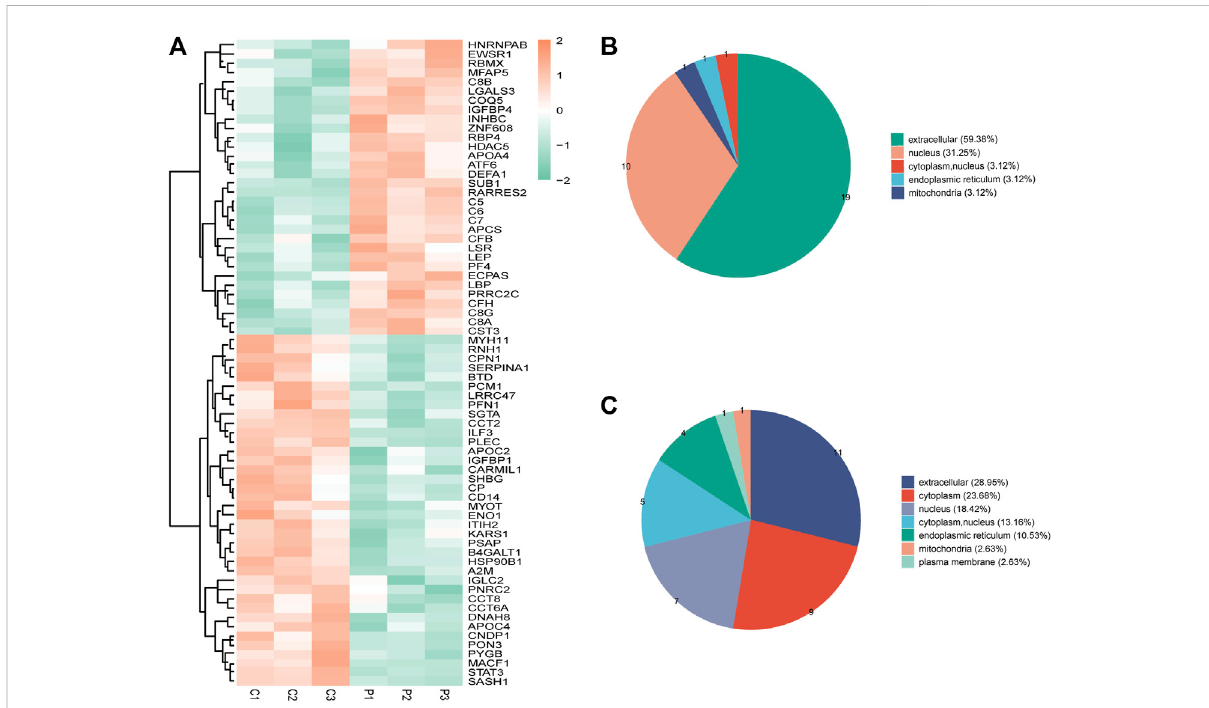
FIGURE 1 (A) Clustering heat map of the protein expression patterns of different groups. Red color indicates higher expression, while green indicates lower expression. Proteins without signi fi cantly differential expression were shown in white. (B) Distribution of the subcellular lacalization of downregulated expressed proteins for PCOS vs control (C) Distribution of the subcellular localization of upregulated proteins for PCOS vs